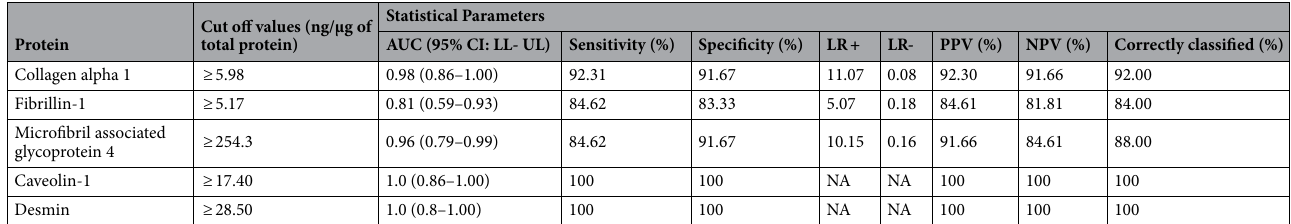
Table 4. Diagnostic parameters of identified proteins to differentiate SLNM + from SLNM- in early breast cancer.